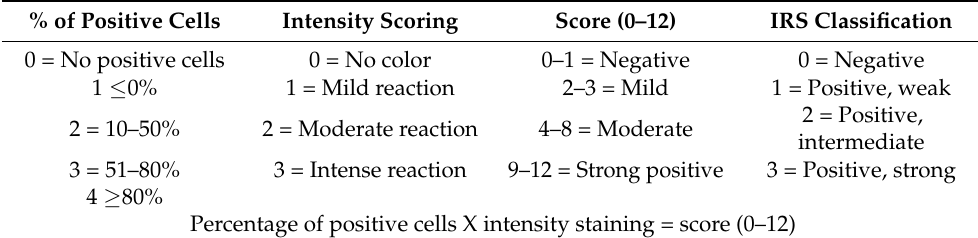
Table 1. Scoring system of ANGPTL4 and IGF1